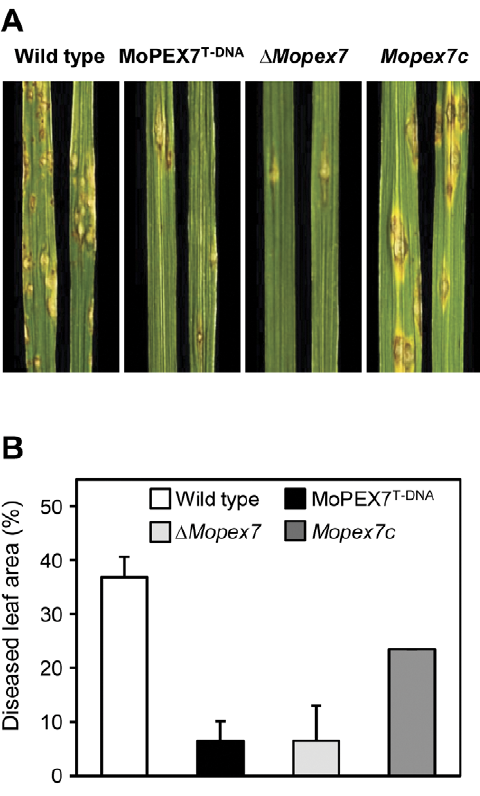
Figure 4. Partial restoration of pathogenicity through addition of glucose. (A) Spray inoculation with 2.5% glucose. Conidial suspension was 1 6 10 5 conidia/ml. (B) Quantitative assay of virulence based on diseased leaf area